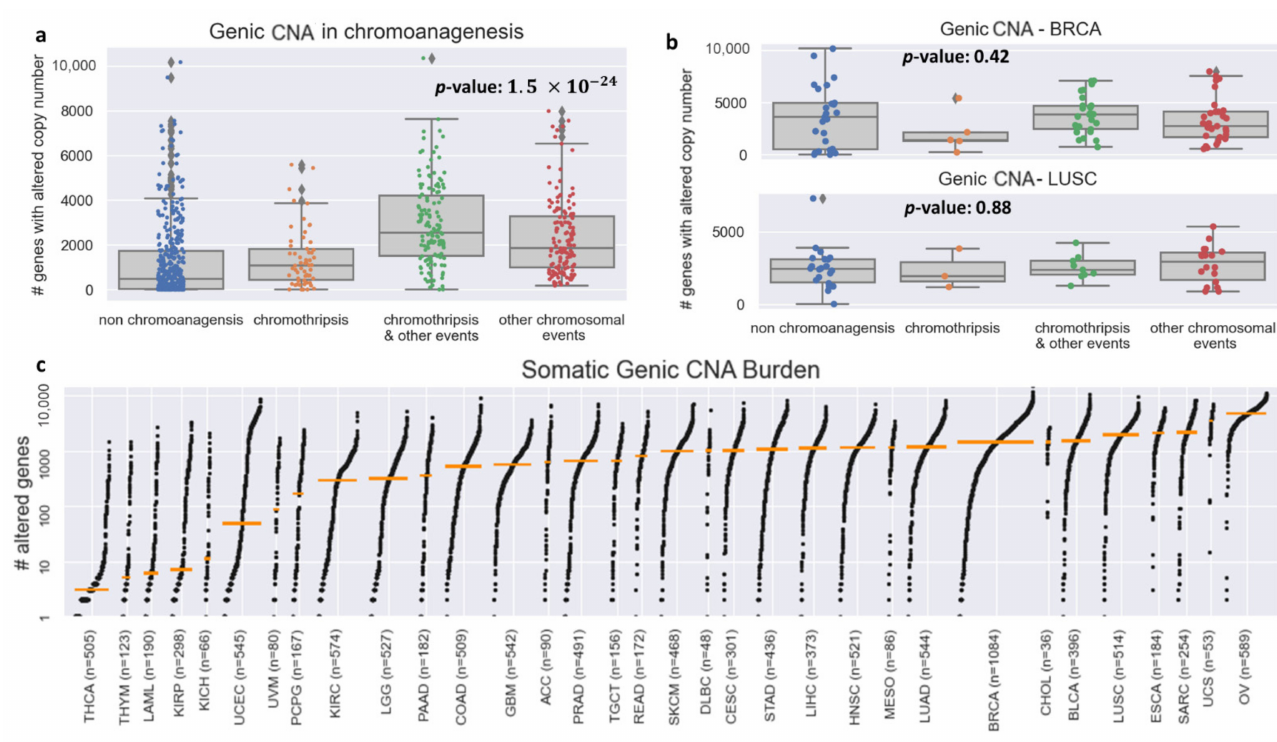
Figure 2. Genic CNA frequency in PCAWG–TCGA. ( a ) Boxplots for the number of genes with altered copy number for each chromoanagenesis subtype. ( b ) Boxplots for the number of genes with altered copy number for BRCA and LUSC patients. ( c ) Genic CNA number distribution in each of the 33 types of cancer included in TCGA. The cancer types are sorted by the median number of copy-altered genes (marked by an orange